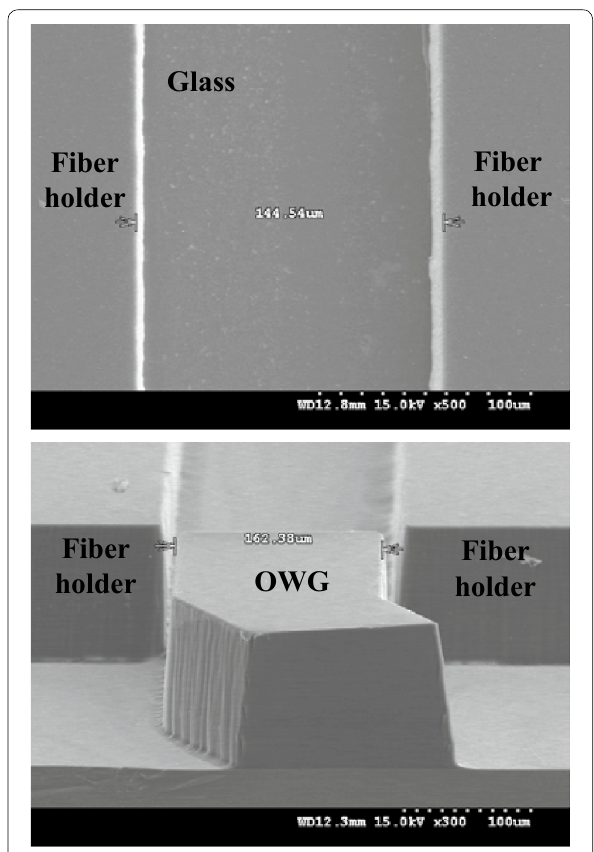
Fig. 2 The FE‑SEM photograph of fabricated OWG